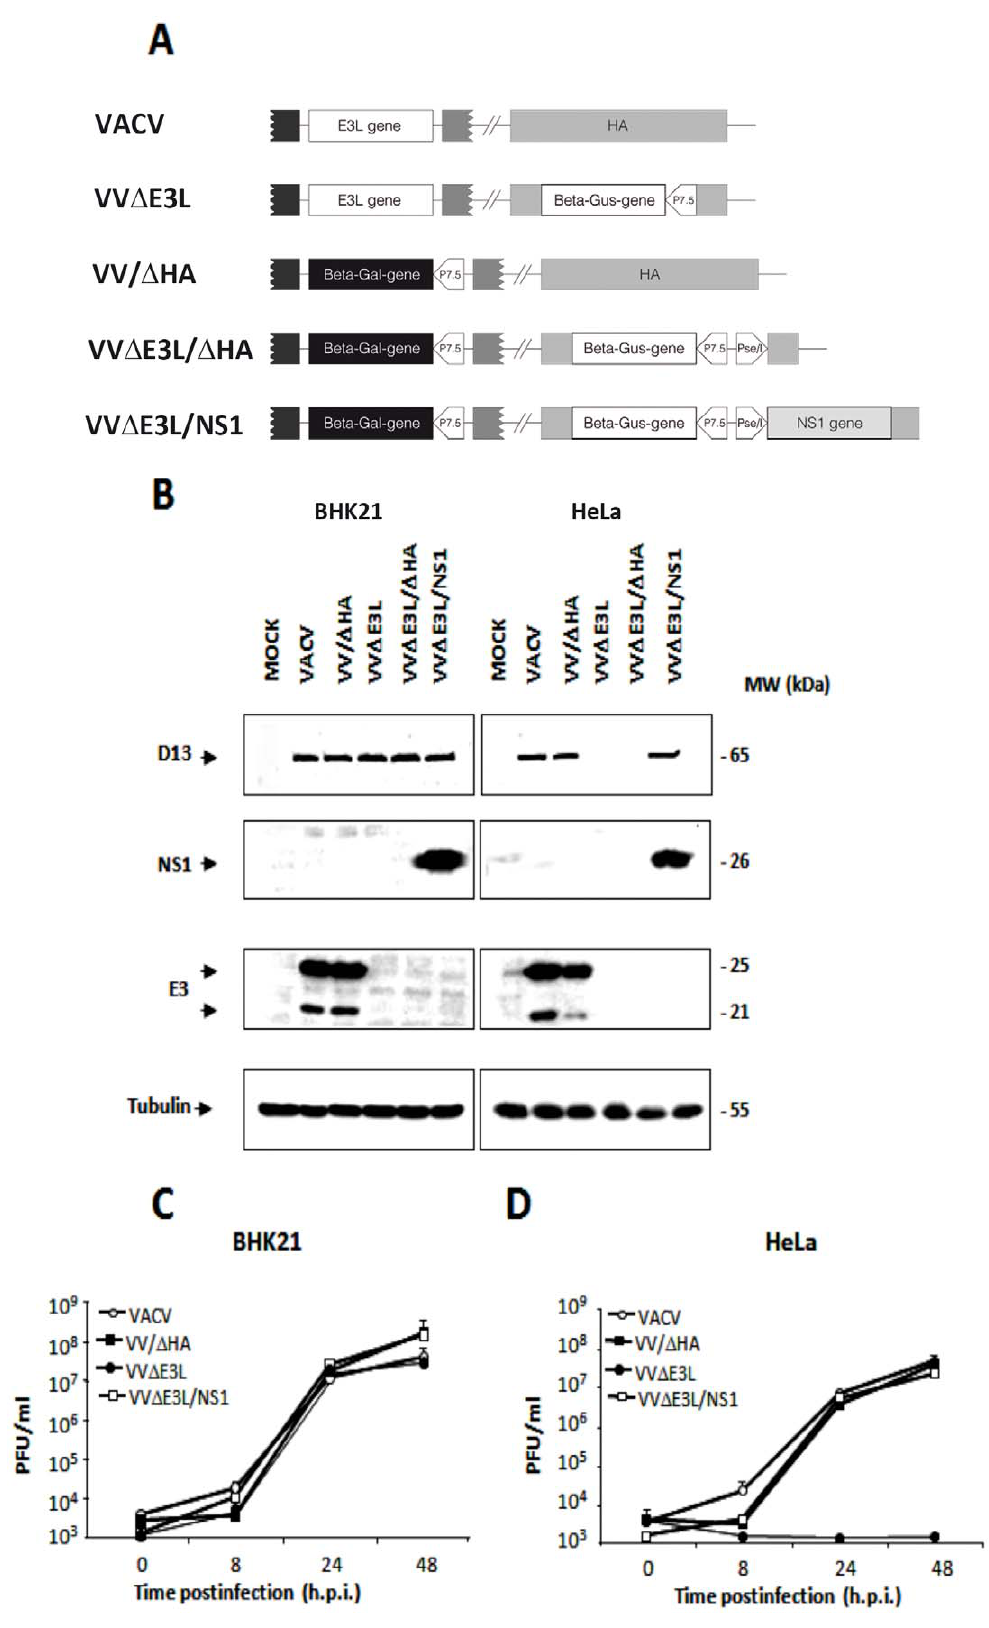
Figure 1. Generation, characterization, and growth properties of VACV recombinants. A. Schematic representation of the VACV recombinants used for this study. The mutant virus VV D E3L was generated by replacing the VACV E3L gene by the b -galactosidase (beta-gal) marker gene [37]. The influenza A (Puerto Rico/8/34) virus NS1 gene was introduced into the HA coding region ( A56R gene) of VV D E3L virus together PLoS ONE |